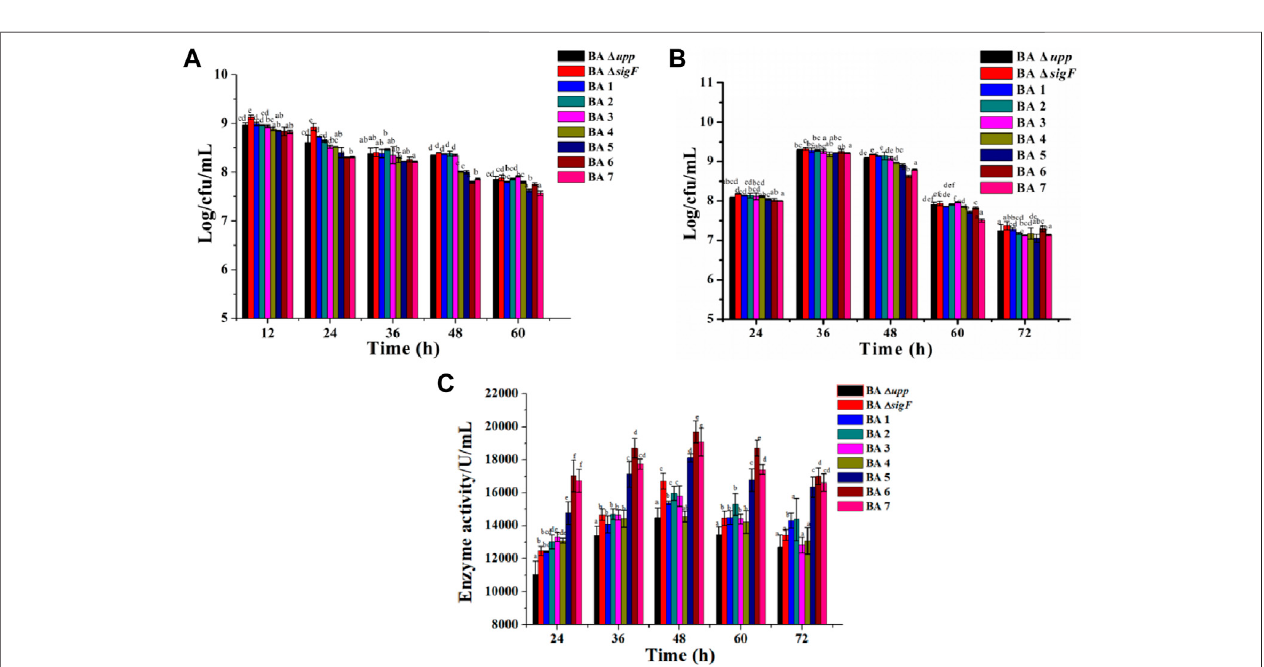
FIGURE 5 | Characterization of the extracellular protease de fi cient strains and parental strain. (A) The viable counts of the different strains was measured by culturinginLBmedium,at12,24,36,48,and60 h,respectively.DataarepresentedasmeanvaluesSD. n =3biologicallyindependentsamples. (B) Theviablecountsof thedifferentstrainswasmeasuredbyculturinginfermentationmedium,at24,36,48,60and72 h,respectively.DataarepresentedasmeanvaluesSD. n =3biologically independentsamples. (C) Alkalineproteaseenzymeactivityassaysoftheextracellularprotease-relatedgenemutantsandBA Δ upp infermentationmedium,at24, 36, 48, 60 and 72 h, respectively. Data are presented as mean values SD. n = 3 biologically independent samples. Means with the different letters are signi fi cantly different according to Duncan ’ s multiple range test at p < 0.05.